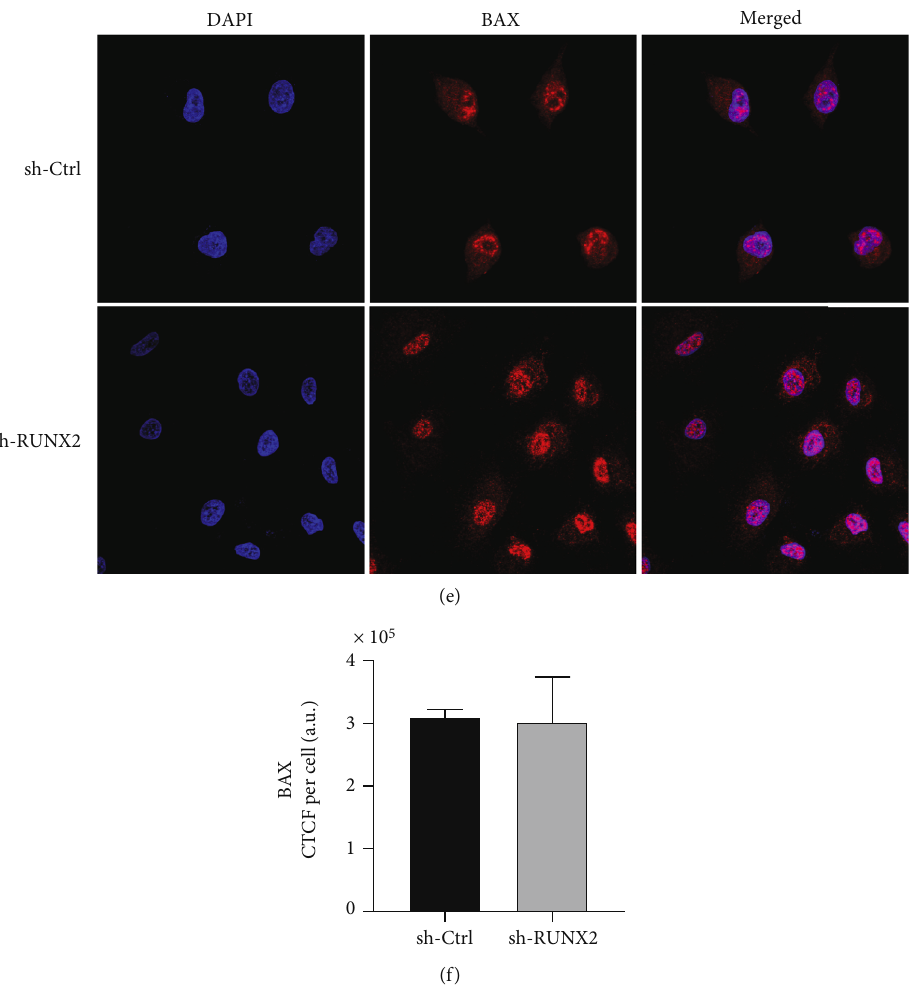
Figure 3: Knockdown of RUNX2 and proapoptotic gene expression levels: BAD and BAX . A549 cells were infected with lentiviral particles coding for sh-RNAs against RUNX2 . BAD (a) and BAX (d) mRNA levels were quanti fi ed by RT-qPCR 48h after infection. Statistical analyses were performed with respect to cells infected with the virus generated with the pLKO.1 empty vector (sh-Ctrl.). ∗ p < 0 : 05 (three independent experiments). Protein levels were analyzed with immuno fl uorescence assays. BAD protein expression mitochondrial pattern (b). BAX protein expression with nuclear localization (e). Total cell fl uorescence (CTCF) of protein was evaluated ( CTCF = integrateddensity − areaof selected cell × mean fluorescence of background readings ) using the software ImageJ 1.52p (c,